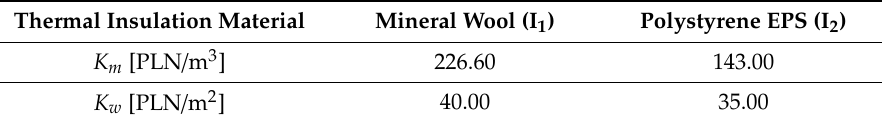
Table 8. The costs of purchase and implementation of thermal insulation.